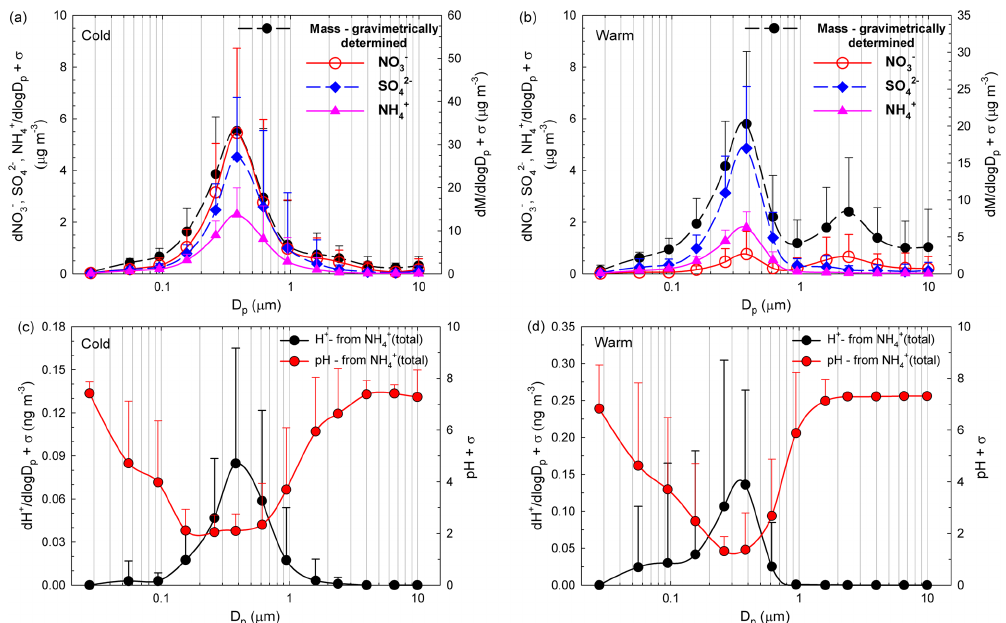
Figure 5. Size distribution of averaged aerosol mass and NO − accompanied by the size distribution of ISORROPIA-II-estimated pH and H + mass concentration over both the cold (c) and the warm (d)